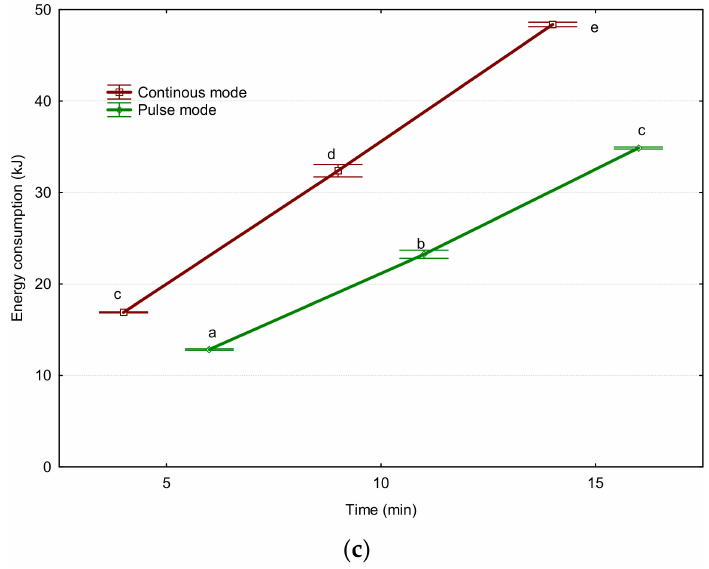
Figure 3. Impact of ultrasonic treatment parameters on energy consumption during the extraction of bioactive substances from hawthorn berries: ( a ) amplitude 12 µ m, ( b ) amplitude 24 µ m, ( c ) amplitude 36 µ m. The bars marked with the same letter are not statistically significantly different ( p <